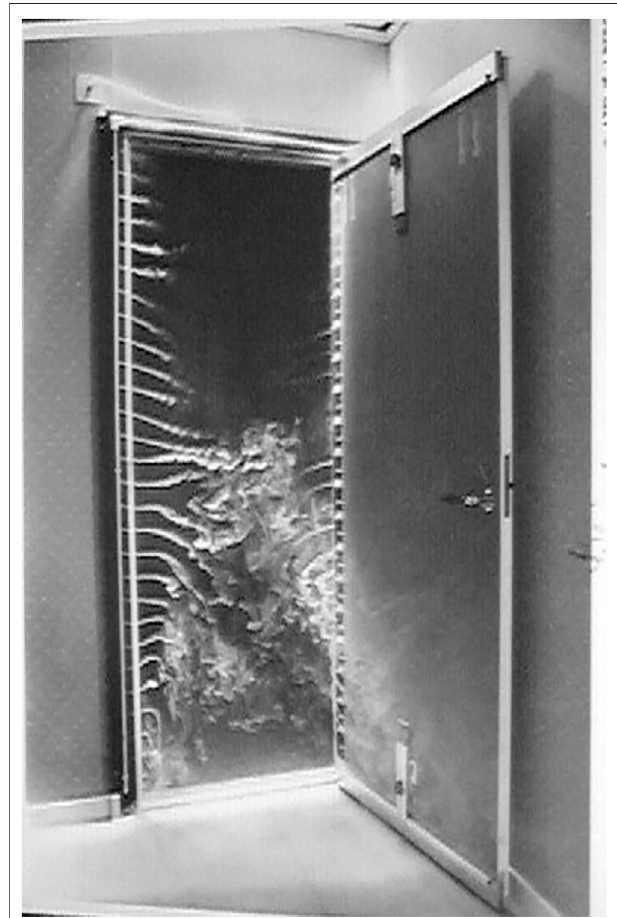
FIGURE1| Bidirectional fl owinadoorwaycausedbytheroom-to-room temperature difference.